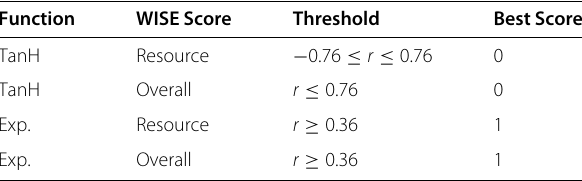
Table 2 Optimal thresholds used in the experiments